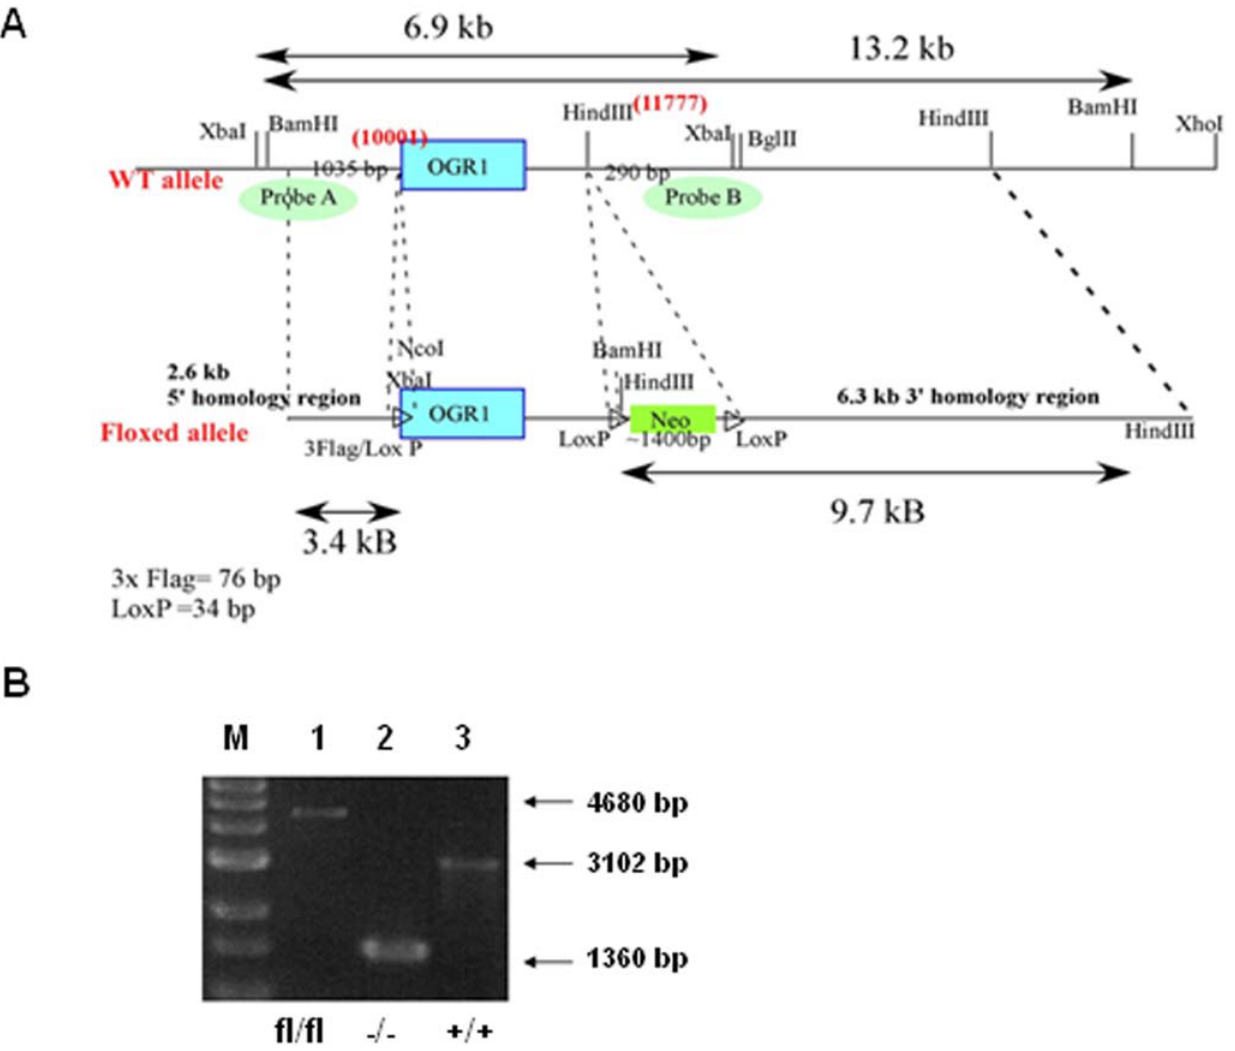
Figure 1. Generation of conditional OGR1 deficient mice. (A) Strategy for constructing the OGR1 targeting vector. (B) Genotyping was performed to identify floxed (FL), 2 / 2 (KO) and + / + (WT) mice.